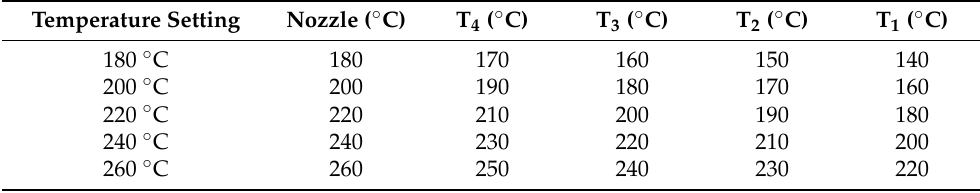
Table 2. Exact temperature profiles used for injection moulding of test specimens.